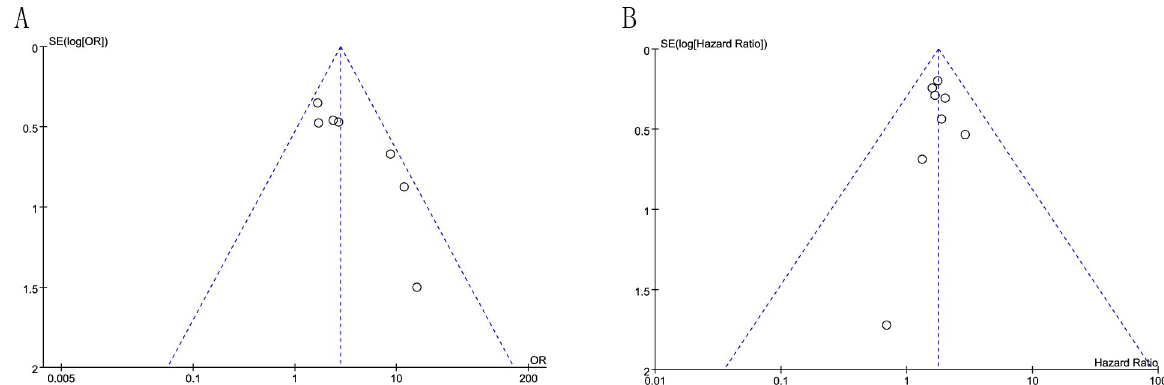
Fig 8. A funnel plot analysis of potential publication bias. ( A) Egger’s test demonstrated significant publication bias for TNM stage ( B) There was not publication bias for OS.